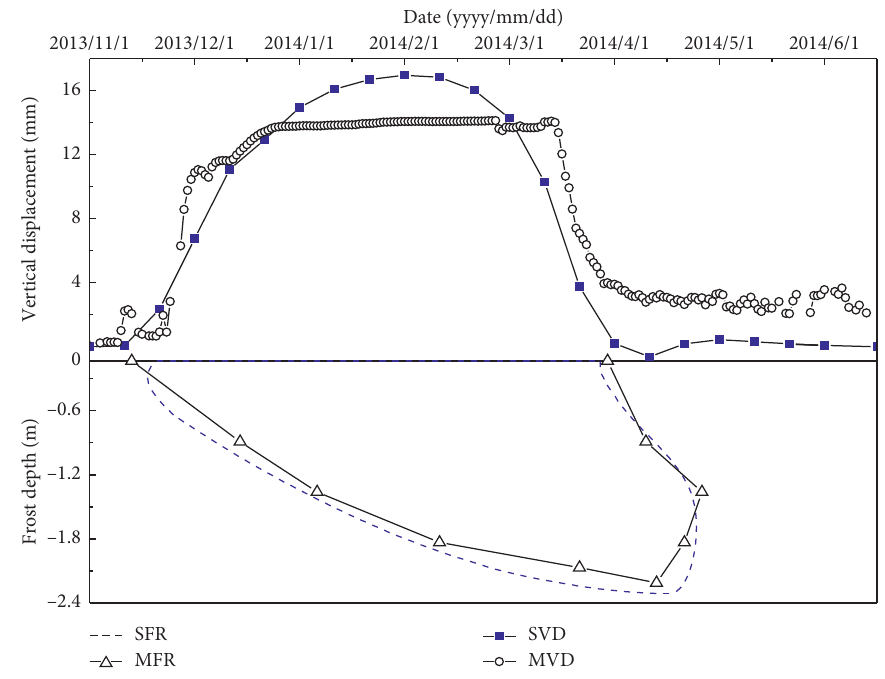
Figure 4: Simulated and monitored frost depth and vertical